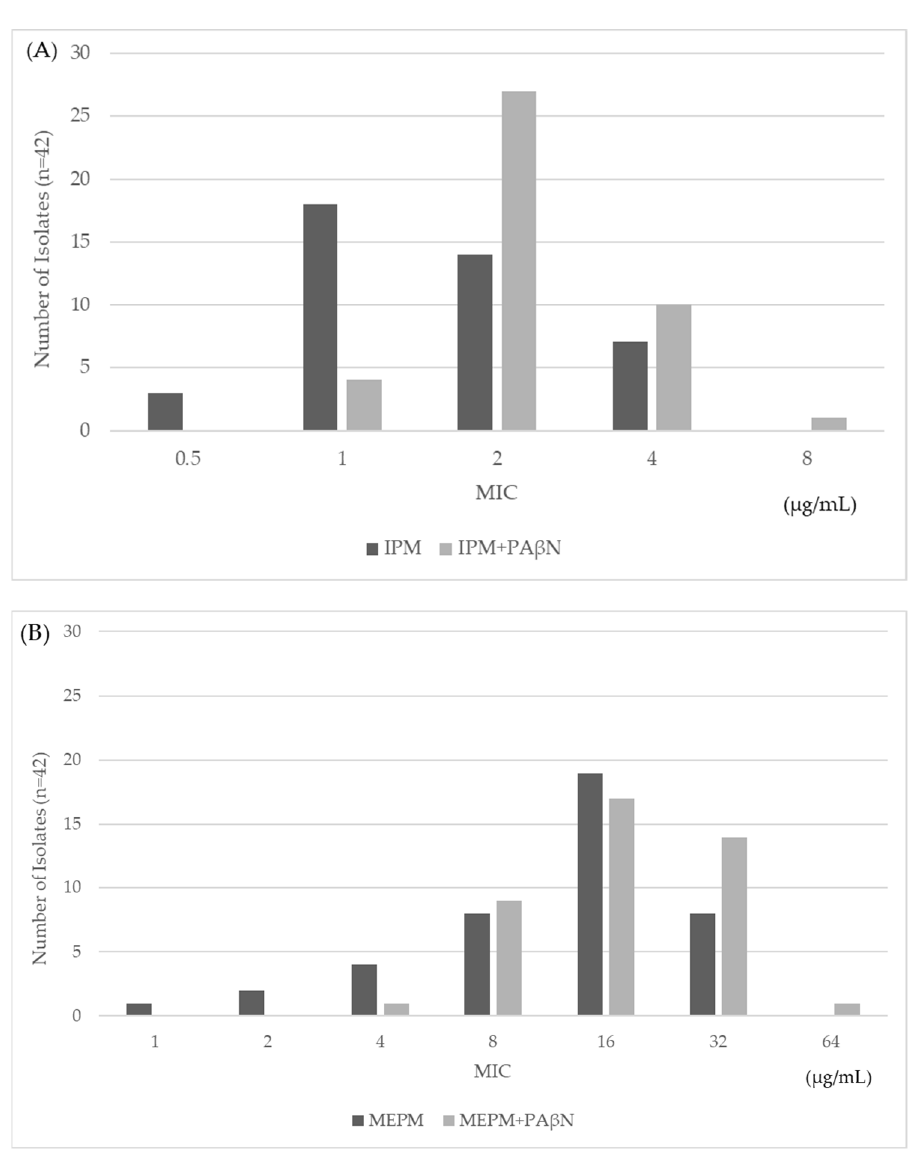
Figure 3. The MICs of IPM ( A ) and MEPM ( B ) with and without the addition of PA β N in IMP-6- producing E. coli strains.